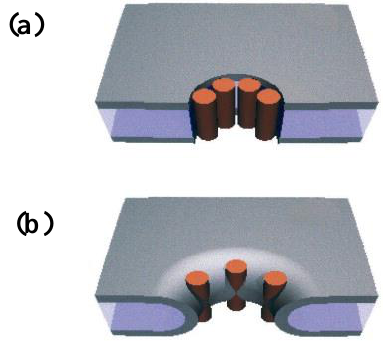
Figure 6. Two possible models for pores ( a ) Barrel-stave pore; ( b ) Toroidal